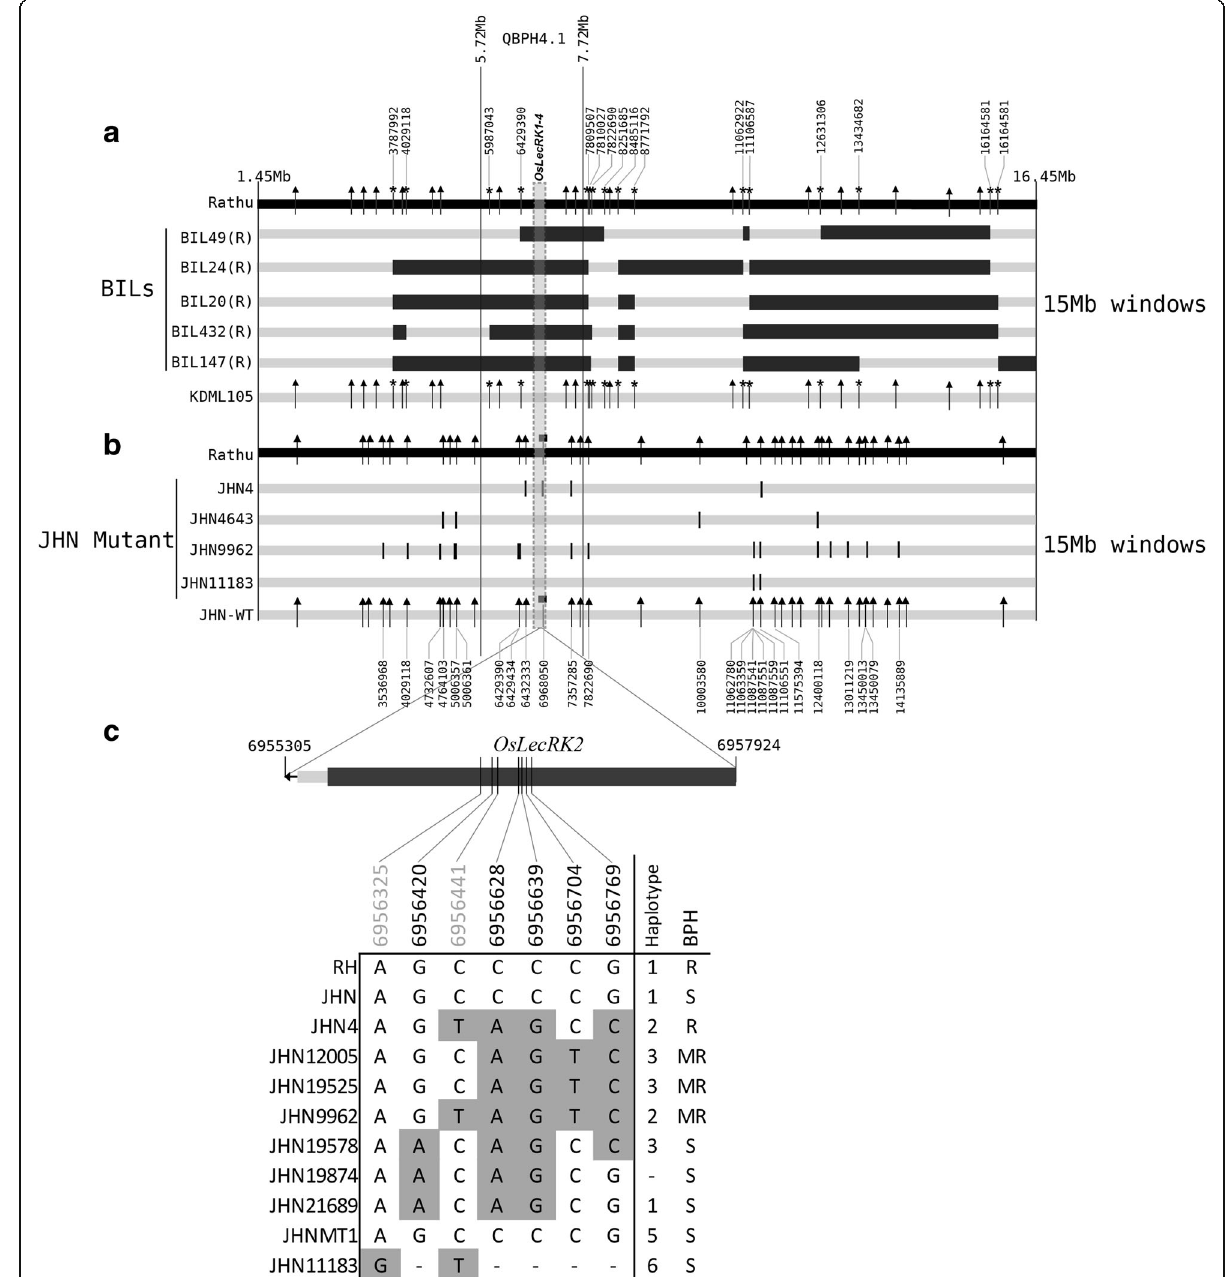
Fig. 5 Graphical genotype analysis of 15 Mb spanned QBPH4.1 genomic region. a The extreme resistant BILs were analyzed with KDML105 and RH, b The JHN mutant lines were analyzed with JHN-WT and RH, c Haplotype patterns at seven novels amino acids of mutant lines. SNPs at position 6,956,325 and 6,956,441 were developed as the KASP markers for HP analysis. Filled squares represented gene-specific SNPs, filled arrowheads represented intergenic SNPs, and asterisks represented the recombination